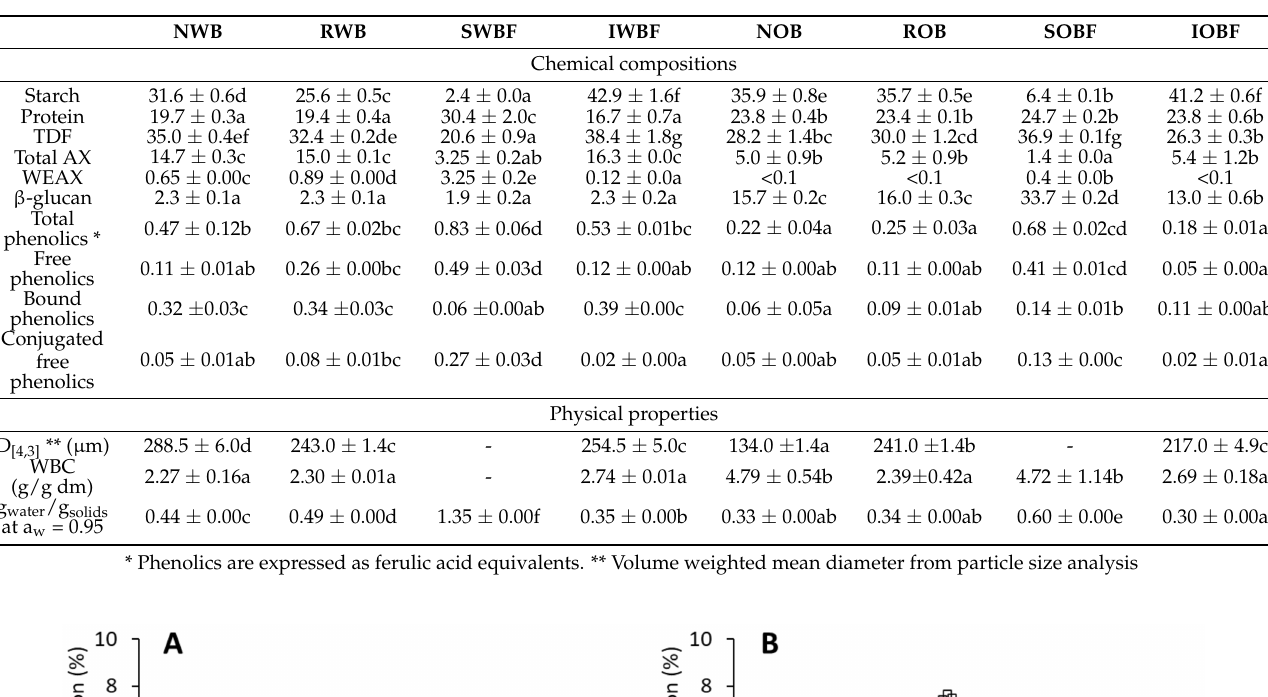
Table 2. Chemical and physical properties of bran and bran fractions from wheat and oat (samples abbreviations are reported in Table 1). Composition is expressed as grams of substance per grams of dry matter. Different letters in the same row indicate statistically significant differences ( p < 0.05).